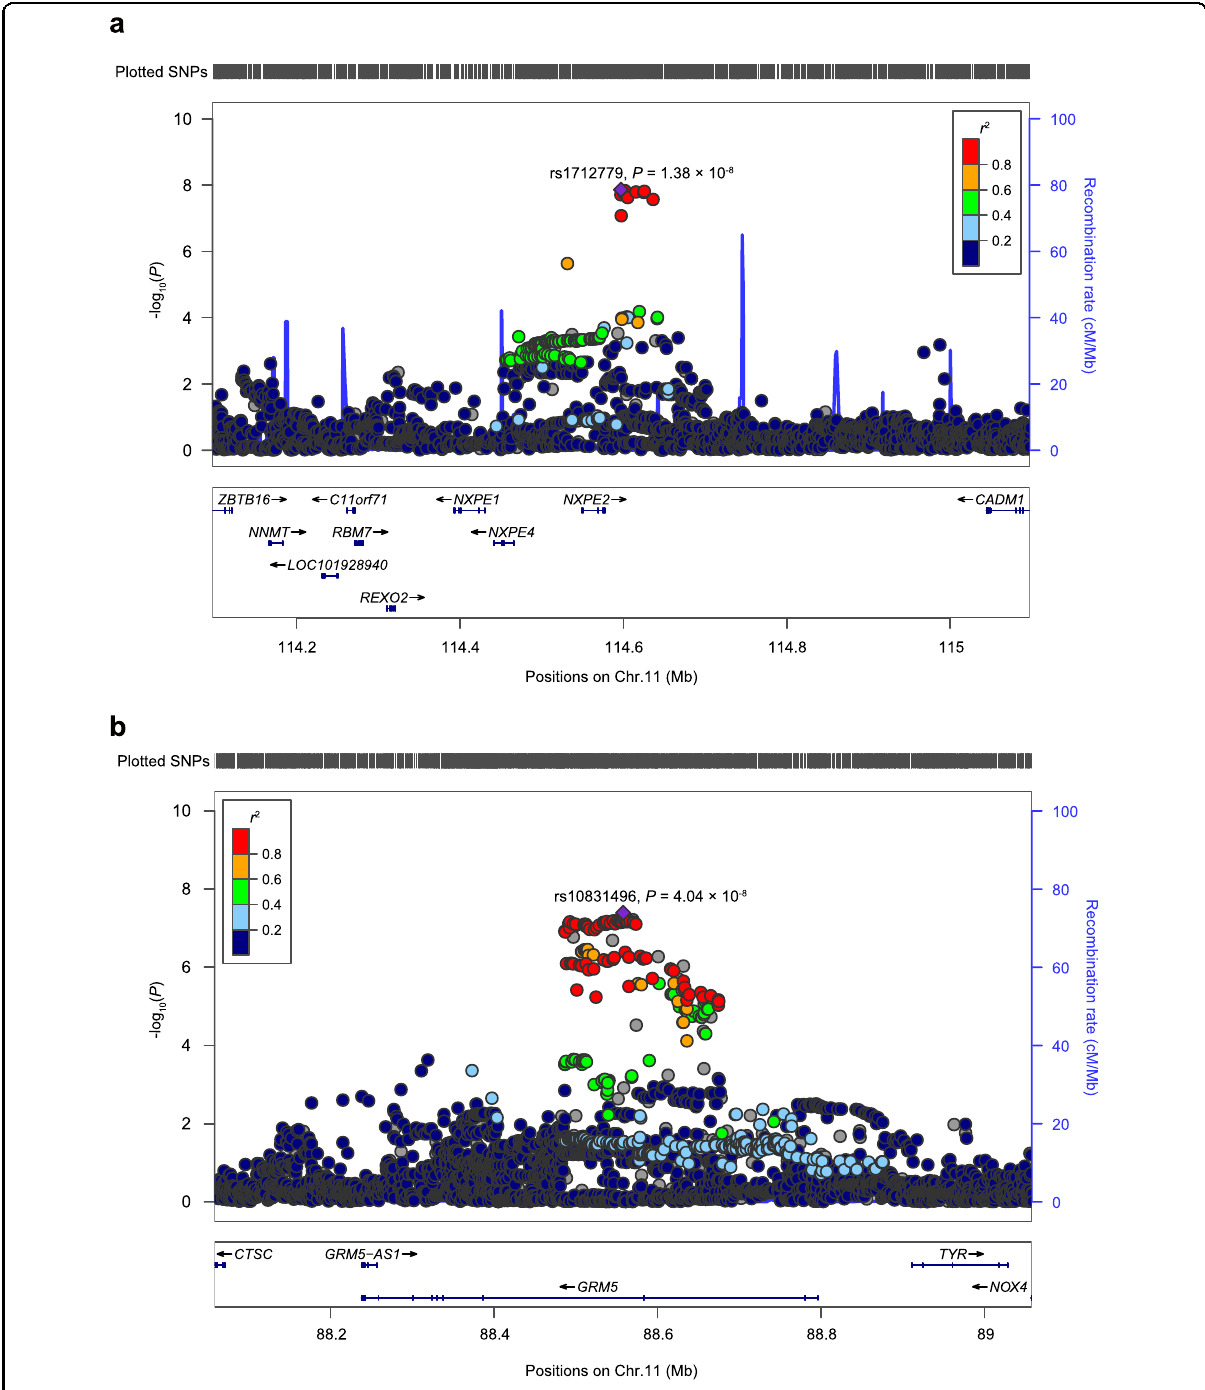
Fig. 3 Regional plots for associations in the regions surrounding the rs1712779 and rs10831496 in the main meta-analyses. Results are shown for the SNPs within 1 mega bases (Mb) regions surrounding the index SNPs rs1712779 at Chr. 11q23.3 ( a ) and rs10831496 at Chr. 11q14.2 ( b ). The P values of the SNPs in these two regions in the main meta-analyses (adjusting for age, gender, and comorbidities) of Huoshenshan and Union cohorts are shown. Genomic positions are based on human genome assembly hg19. The P values of rs1712779 and rs10831496 are shown as purple diamonds. The linkage disequilibrium (LD) values ( r 2 ) to the index SNPs (rs1712779 or rs10831496) for the other SNPs are indicated by marker color. Red signi fi es r 2 ≥ 0.8, with orange 0.6 ≤ r 2 <0.8, green 0.4 ≤ r 2 <0.6, light blue 0.2 ≤ r 2 <0.4, and blue r 2 <0.2. The estimated recombination rates in East Asian population (from the 1000 Genomes Project, November, 2014) are plotted in light blue. The East Asian population from the 1000 Genomes Project consists of 504 subjects from CHB (Han Chinese in Beijing, China), CHS (Southern Han Chinese), CDX (Chinese Dai in Xishuangbanna, China), JPT (Japanese in Tokyo, Japan), and KHV (Kinh in Ho Chi Minh City, Vietnam). Chr, chromosome; SNP, single-nucleotide polymorphism; cM, centi